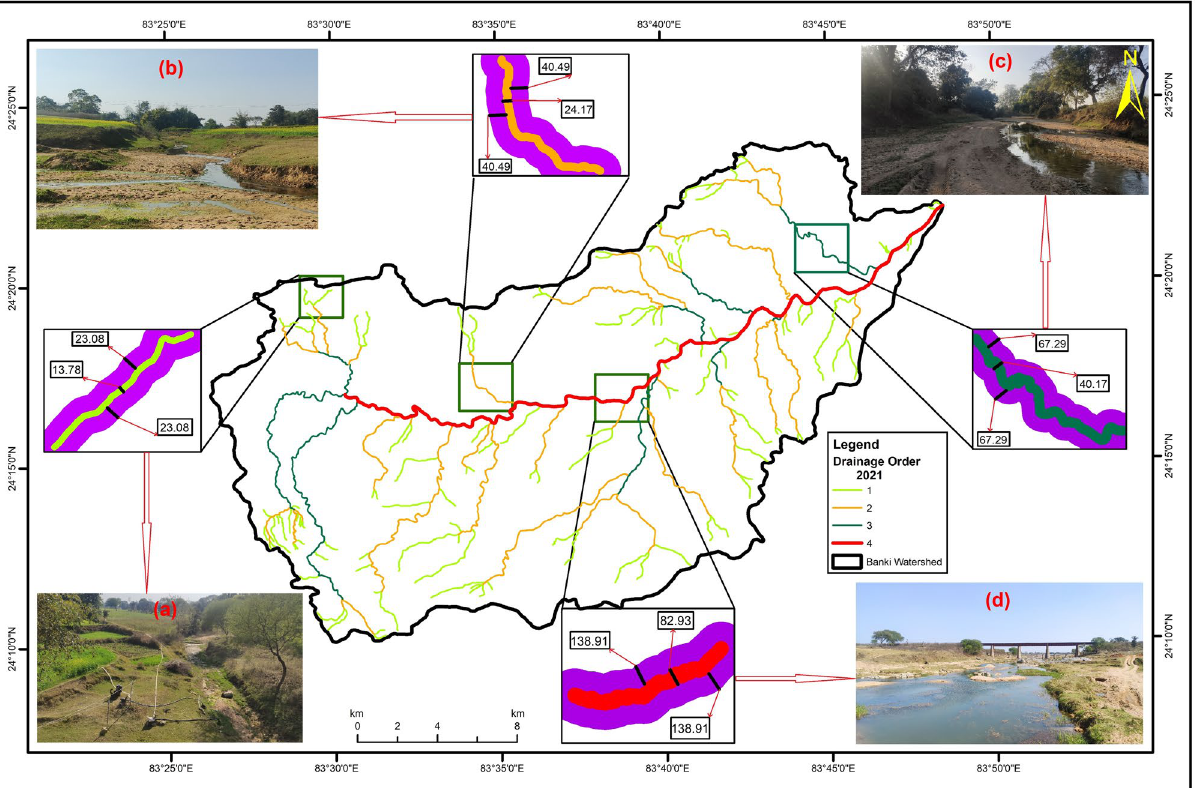
Figure 2. Delineation of W RAB and W LAB using watershed factor DDR and M SW . DDR is the ratio of Dd 1977 and Dd 2021 . M SW is the mean stream width. The W RAB and W LAB are half of the W AB and greater than the M SW . ( a ) Displaying 1st order M SW , W RAB, and W LAB . ( b ) Displaying 2nd order M SW , W RAB, and W LAB . ( c ) Displaying 3rd order M SW , W RAB, and W LAB . ( d ) Displaying 4th order M SW , W RAB, and W LAB